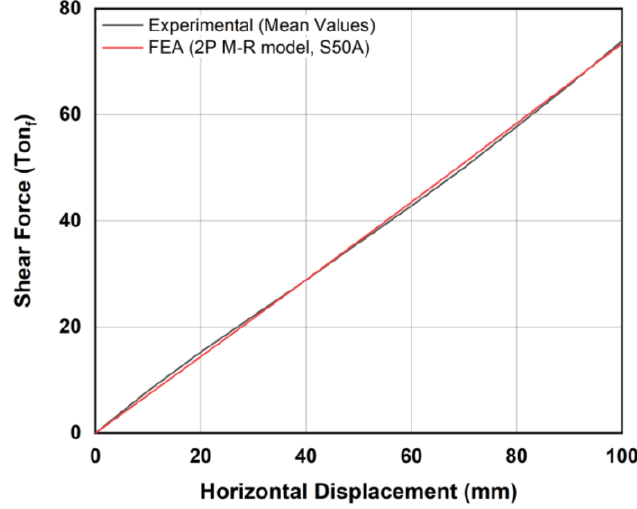
Figure 13. Comparison of shear force-displacement graph between the experiment (mean values of 10 test results) and the numerical simulation (2P M-R model results) at a shore hardness of 50A.